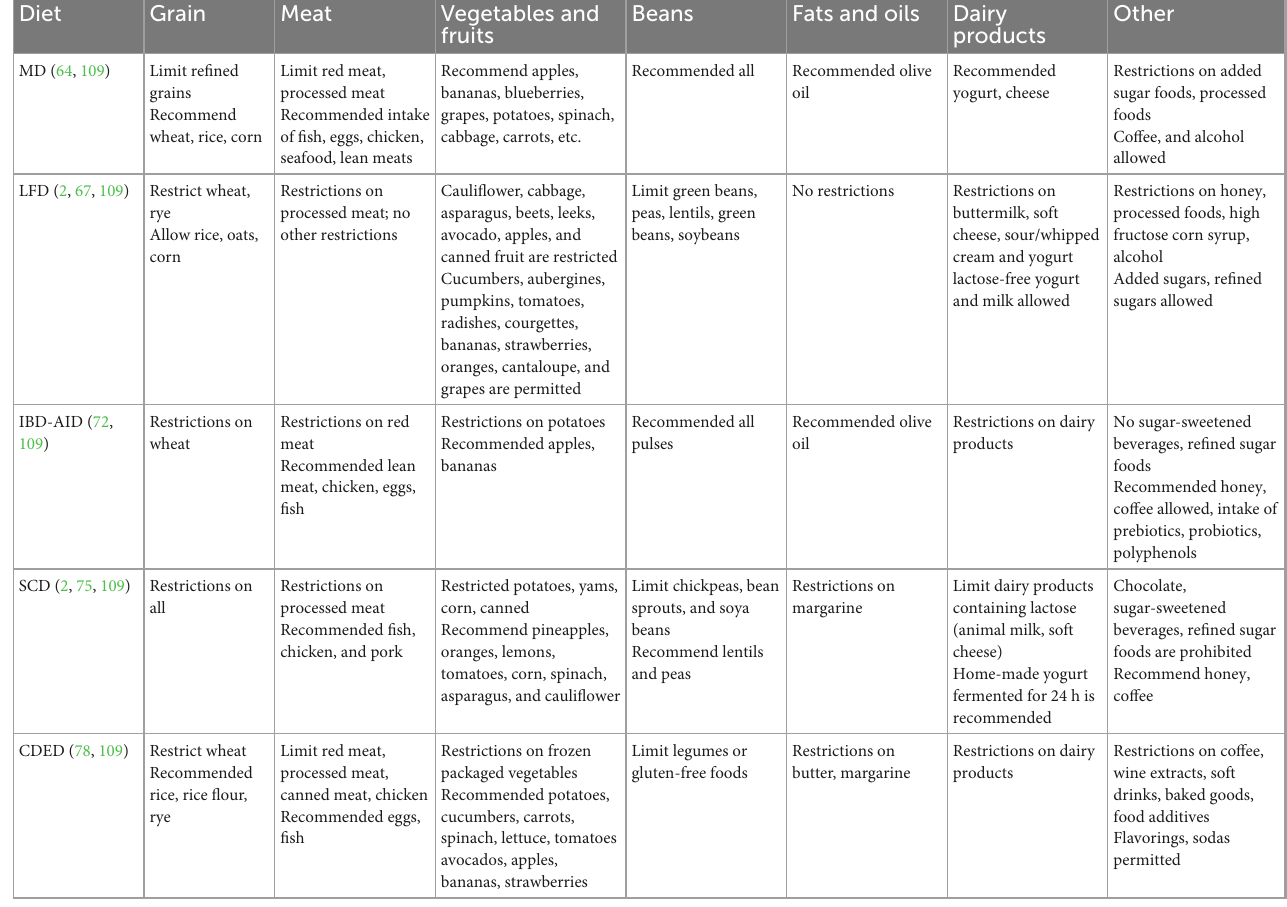
TABLE 4 Types of foods recommended or restricted by dietary